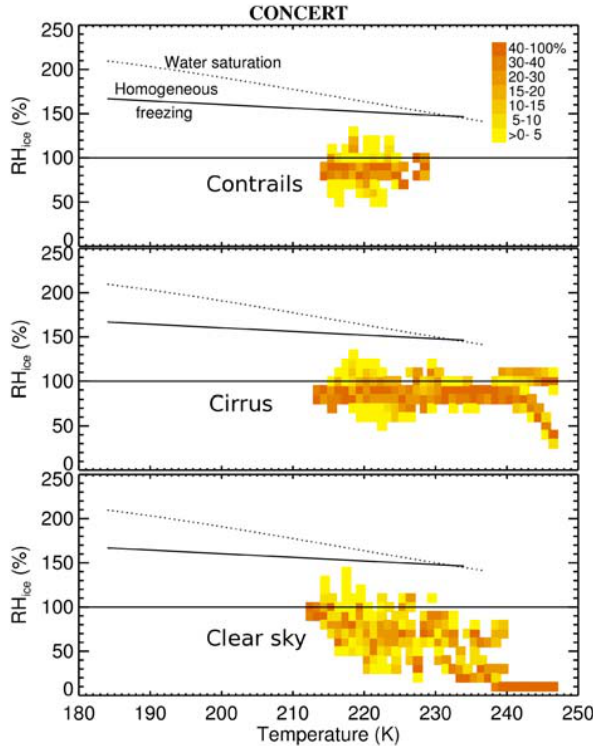
Fig. 4. Frequencies of occurrence of relative humidities over ice versus temperature in contrails (upper panel), cirrus clouds (middle panel) and clear sky (lower panel) observed during the CONCERT campaign. The thin solid line represents the homogeneous freezing threshold, the dotted line refers to water saturation. The data are sorted in 1 K temperature bins. In each 1 K bin the sum of all data is 100%.